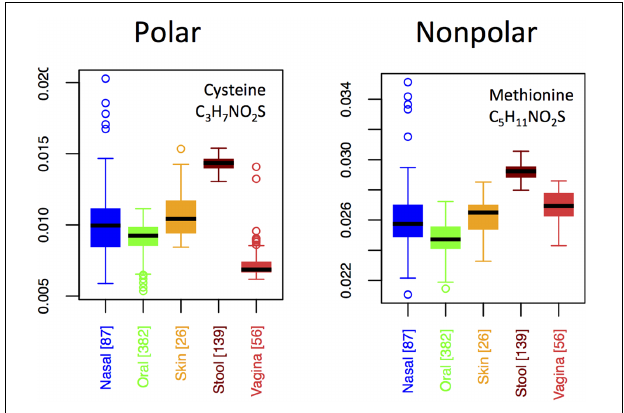
FIGURE 7 | Boxplots showing the fractions of the two S-rich amino acids as a function of body site.